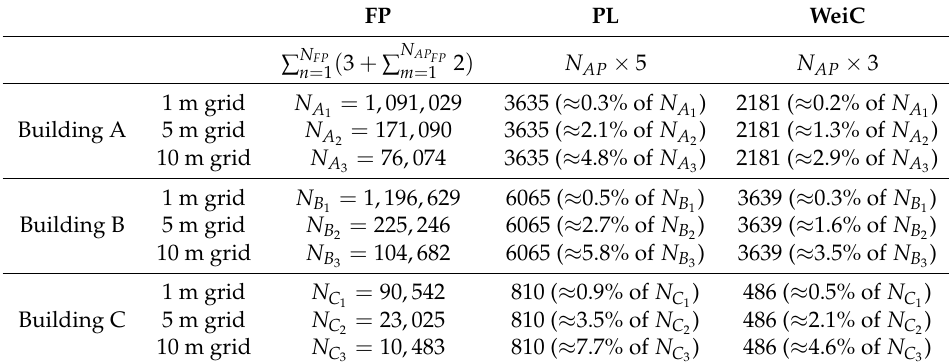
Table 2. Number of the parameters needed to be transmitted for different positioning methods. Examples for buildings A and